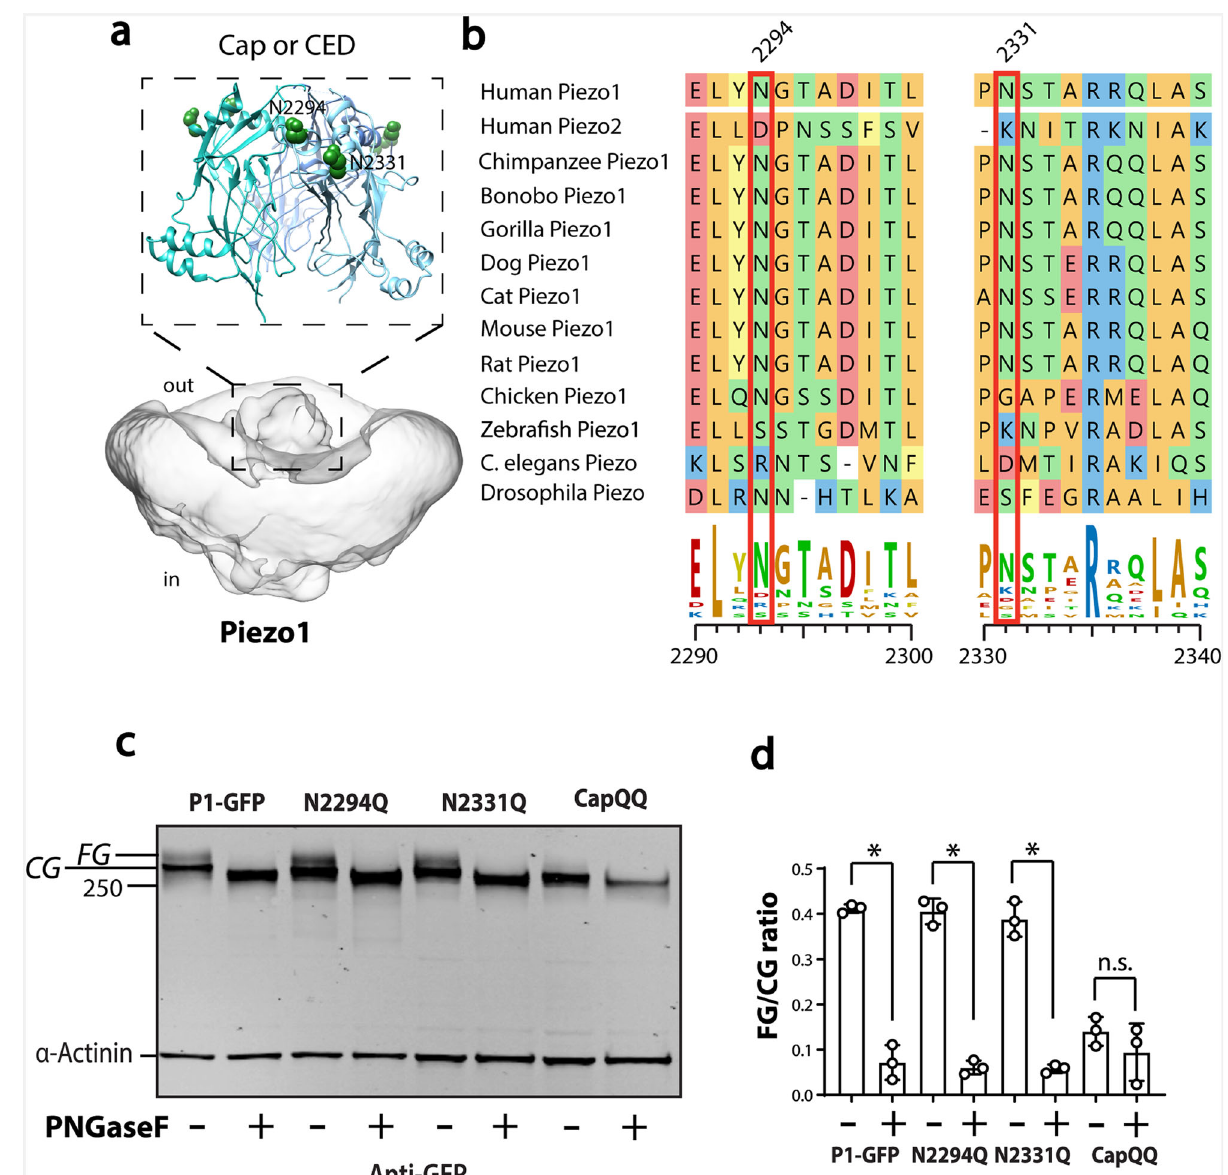
Fig. 3 In fl uence of Asparagine residues in the cap region of human Piezo1 on N-glycosylation. a Two asparagine residues present in the Cap domain of Piezo1. b Multiple sequence alignment illustrates these asparagine residues are highly conserved in Piezo1 homologues. c Representative blot showing the effect of PNGaseF treatment on lysate from HEK293 cells expressing Piezo1-GFP, N2294. N2331Q and N2294Q/N2331Q (CapQQ). d Quanti fi cation of the ratio [FG/CG] of the upper band (FG) and lower band (CG) with and without PNGaseF for Asn mutants in the Cap region. * p < 0.05 determined by Kruskal – Wallis test with Dunn ’ s post-hoc We quantitatively compared the intensity of the upper fully glycosylated (FG) band with the lower core glycosylated (CG) band in replicate experiments (Fig. 3c, d). Comparison between PNGaseF treatment of WT, N2294Q, N2331Q showed patterns that suggested that the upper FG band was removed, and the size of the lower bands were reduced to the level of the un- glycosylated form of the protein. In addition, western blots of the protein from the double mutant N2294Q/N2331Q showed no upper (fully glycosylated) band, while the lower core glycosylated protein was reduced in size. This fi nding suggested that core glycosylation also occurred in the N-terminal domain of Piezo1. This aligns with published fi ndings on Piezo2 that show glycans in the propeller region 44 .